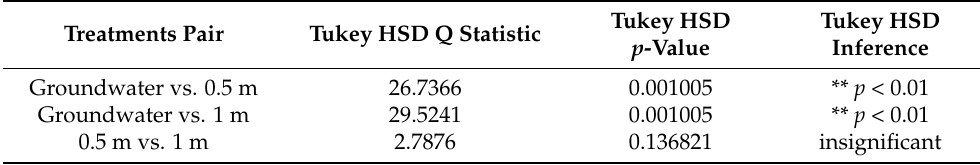
Table 4. Tukey’s honest significance test for total dissolved solids.